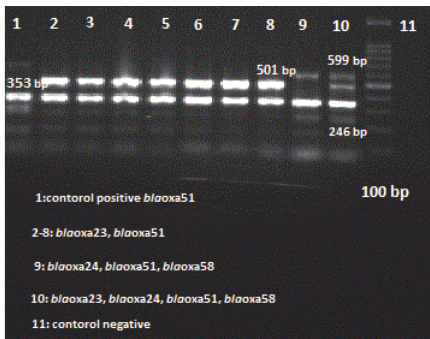
Figure 3: Amplification for presence of oxacillinases genes by multiplex PCR in A. baumannii isolates in